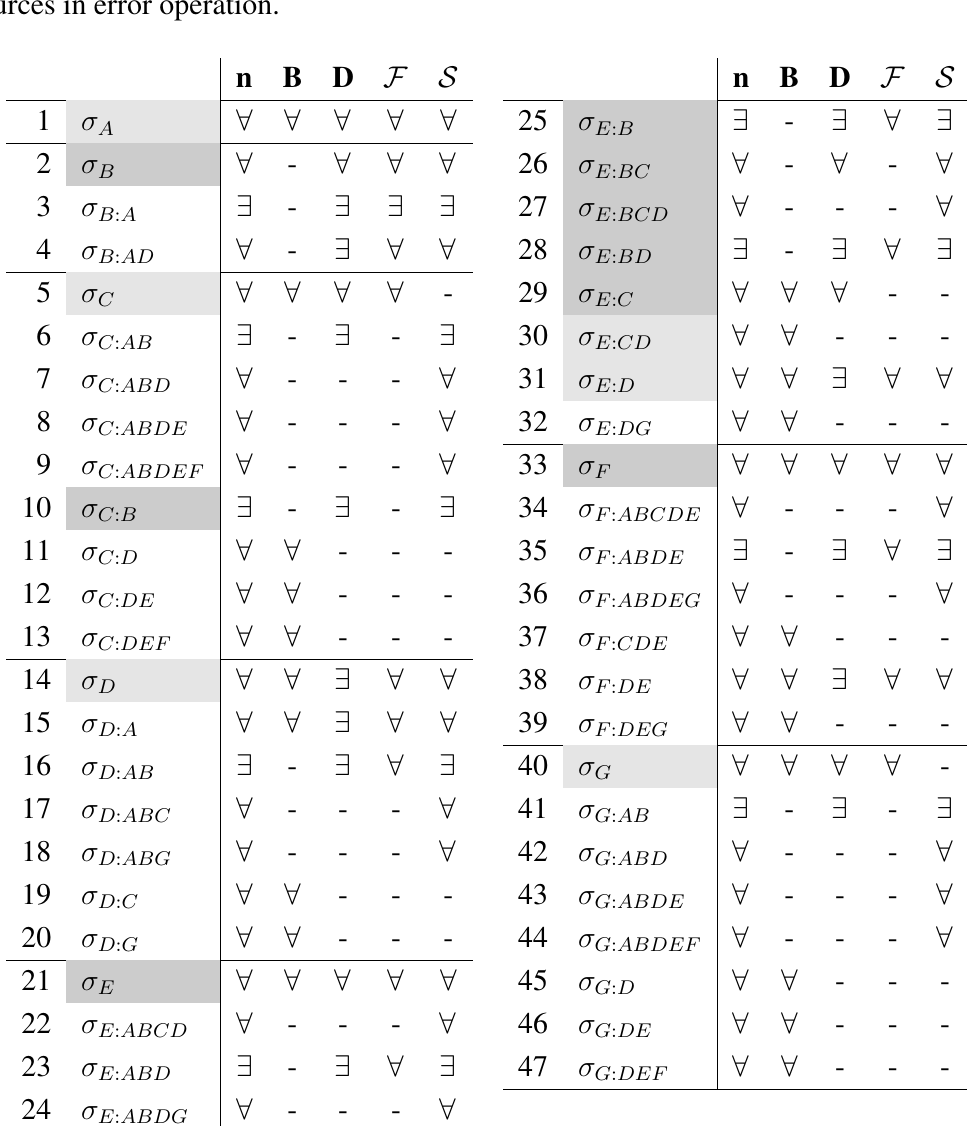
Table 2. In white: placement in home-states, in dark gray: placement that only affect resources in error operation, and in gray: placement in home-states that only affect resources in error operation.